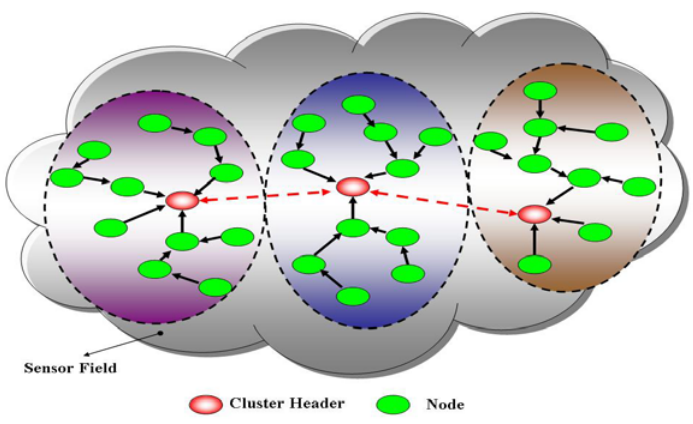
Figure 2. Cluster-based